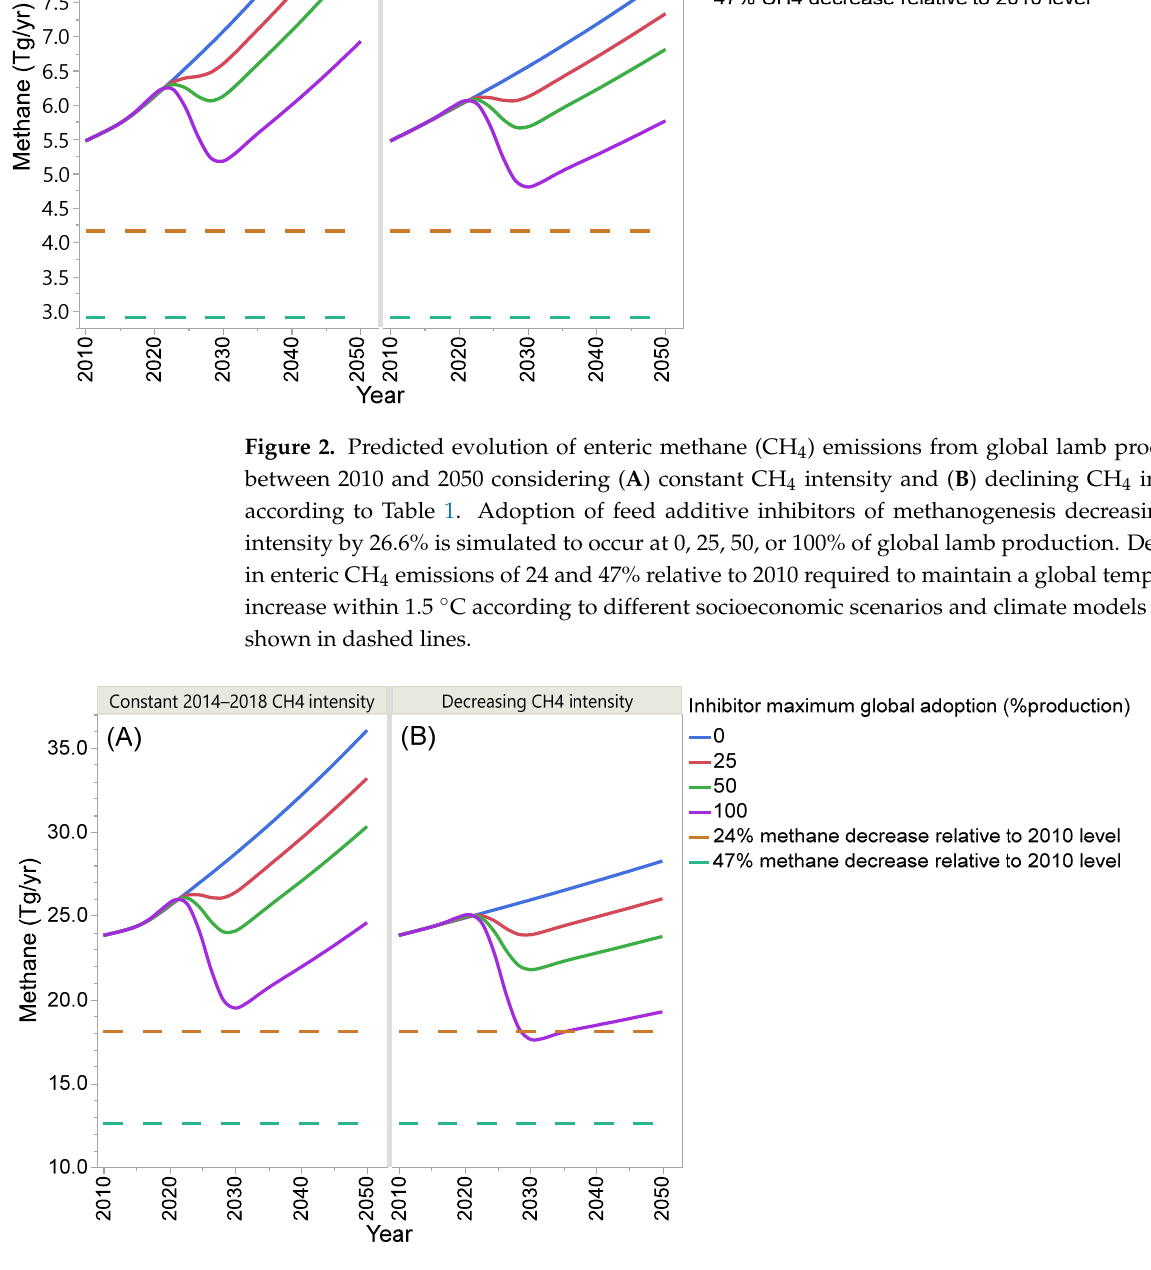
Figure 3. Predicted evolution of enteric methane (CH 4 ) emissions from global bovine milk production between 2010 and 2050 considering ( A ) constant CH 4 intensity and ( B ) declining CH 4 intensity according to Table 1. Adoption of feed additive inhibitors of methanogenesis decreasing CH 4 intensity by 31.8% is simulated to occur at 0, 25, 50, or 100% of global lamb production. Decreases in enteric CH 4 emissions of 24 and 47% relative to 2010 required to maintain a global temperature increase within 1.5 °C according to different socioeconomic scenarios and climate models [15] are shown in dashed lines.